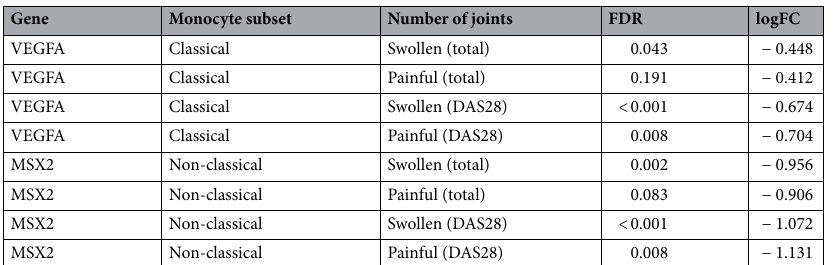
Table 2. Results of the association analysis between clinical signs (swollen/painful) and gene expression in subsets of monocytes. The false discovery rate (FDR) was estimated for each clinical variable separately due to small sample size. FDR estimated false discovery rate based on all tests performed, logFC logarithm of the fold change of the expression levels between experimental